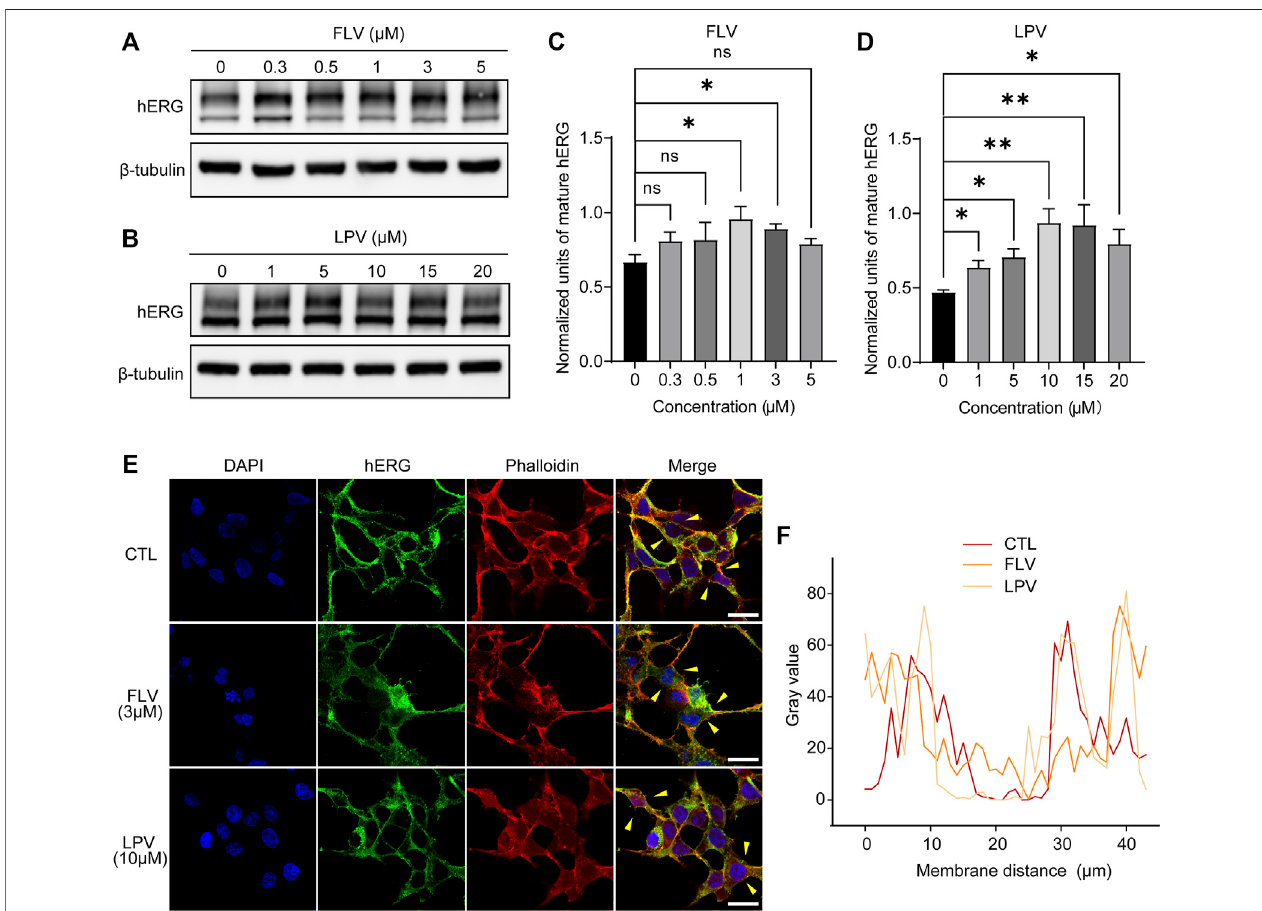
FIGURE 4 | FLV and LPV facilitate the intracellular maturation of the hERG protein. (A,B) Western blot of mature (155KDa, above) and immature (135KDa, below) hERG protein after 24 h of incubation with FLV from 0.3 to 5 μ M or LPV from 1 to 20 μ M, respectively, along with internal control β -tubulin. (C,D) Densitometric evaluations of normalized mature hERG. (E,F) Immunostaining images of HEK-hERG stained with hERG (green), F-actinin (red, phalloidin), and DAPI (blue) before (CTL) and after 24 h of 3 μ M FLV and 10 μ M LPV treatment. Yellow arrowheads represent the area showing plasma membrane hERG staining. Scale bar: 10 µm. The levels of hERG without signi fi cant change at the membrane level after drug application are noted through a line scan plot showing co-localizing intensities of the hERG and F-actinin.